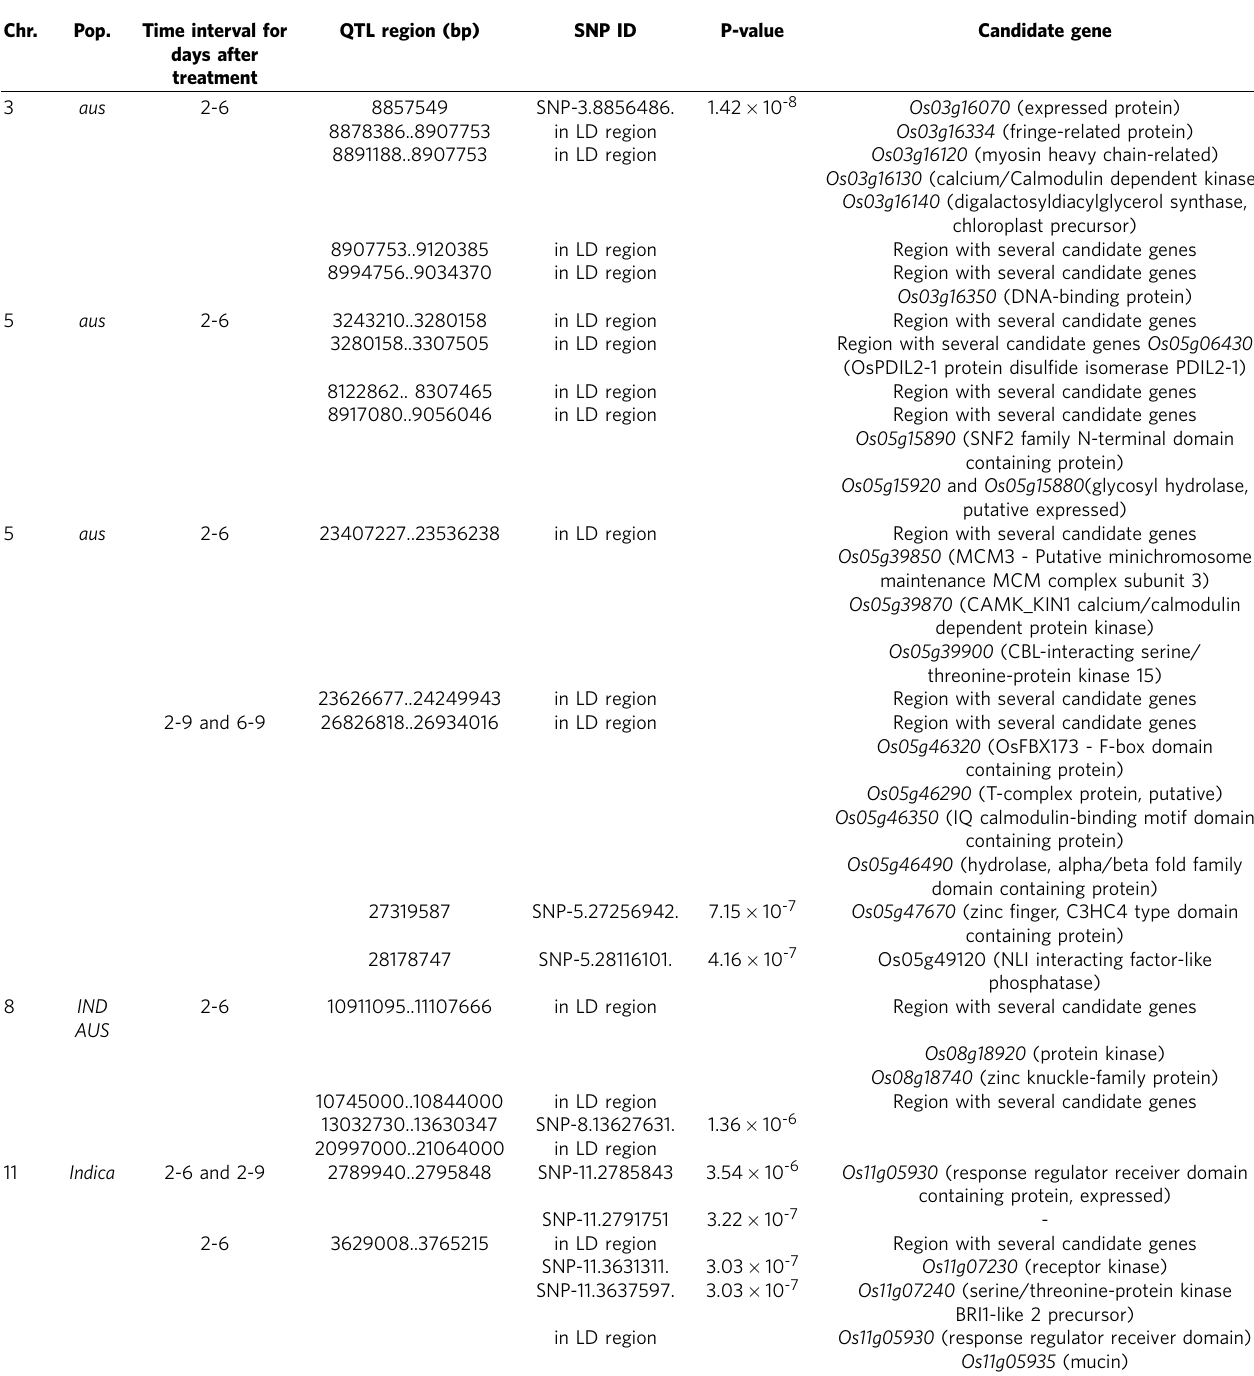
Table 1 | Summary of candidate genes and local linkage disequilibrium region underlying the most significant using the interaction model